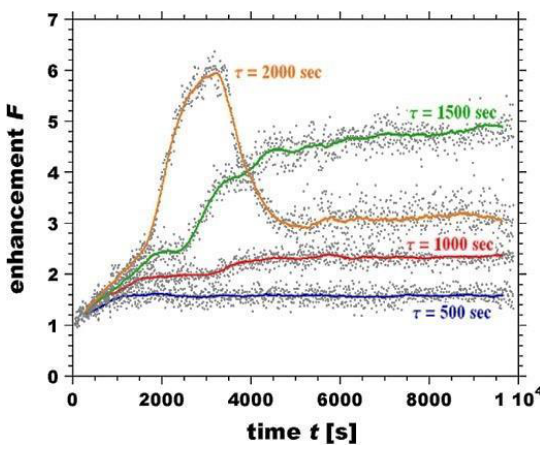
Figure 10. Time evolution of density enhancement factor, F , for ion transmission for different discharge times, τ . (From [18], Copyright 2011, with permission from